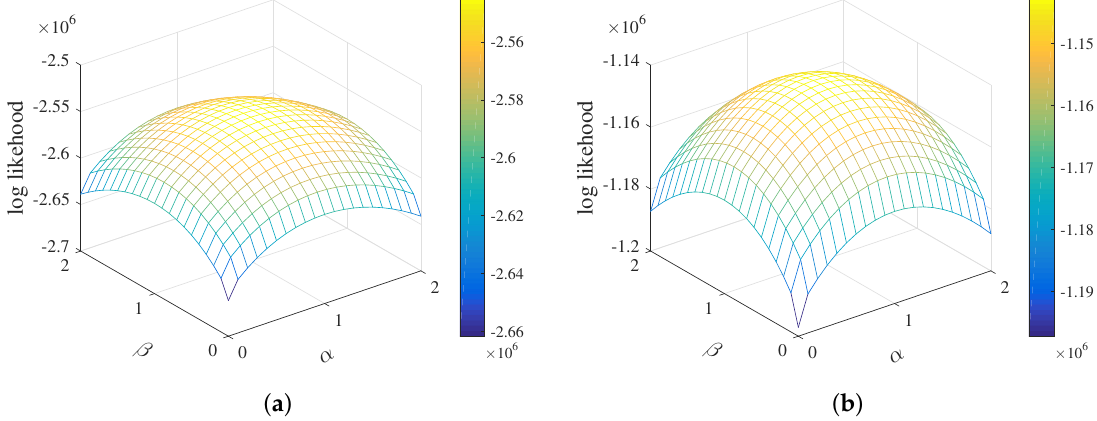
Figure 6. The relationship between log-likelihood of DestiFlow and parameters α and β . ( a ) The relationship between log-likelihood of DestiFlow and parameters α and β on weekday. ( b ) The relationship between log-likelihood of DestiFlow and parameters α and β on